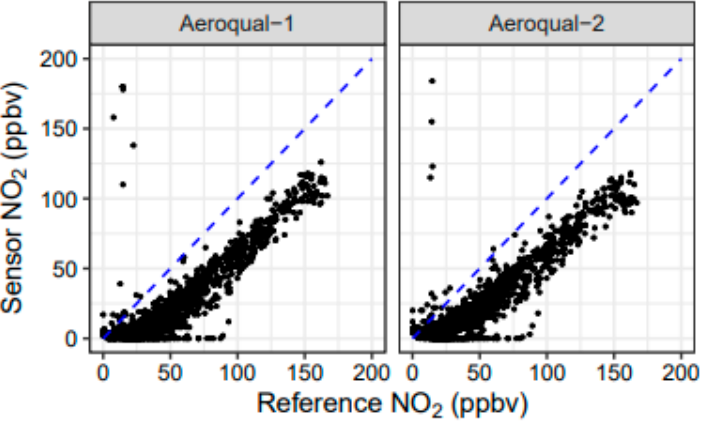
Figure 12. Scatterplot of sensor NO 2 measurements versus reference NO 2 measurements for 33 experimental burns at the Fire Sciences Laboratory in 2018.